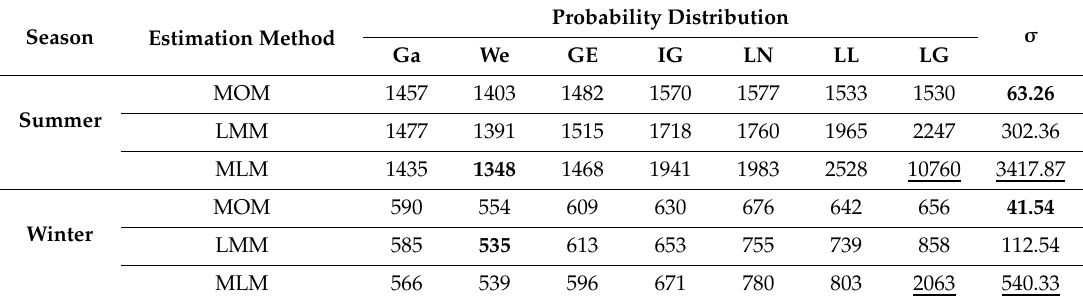
Table 2. Estimates of the 1% quantile of seasonal maximum flows (m 3 / s) from the period 1951–2016 at the Prosz ó wki gauging station and assuming selected two-parameter distributions along with the standard deviation ( σ ) of